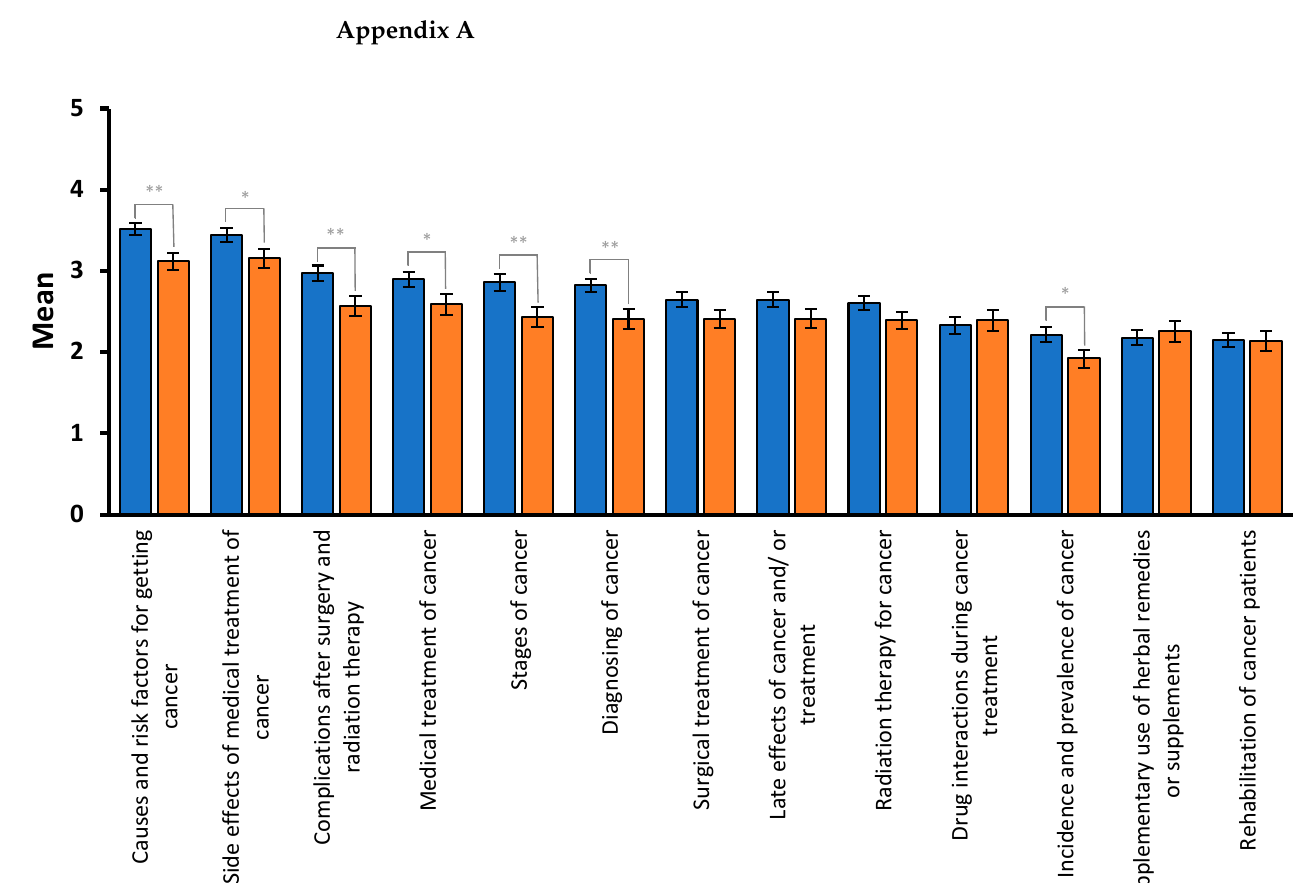
Figure A1. Self-perceived level of knowledge related to the topics about the cancer trajectory and cancer treatment for pharmacists (n = 79) and pharmaconomists (n = 51), respectively. Ratings for knowledge are defined as: 1 No knowledge, 2 very little knowledge, 3 some knowledge, 4 a lot of knowledge, 5 in-depth knowledge. Pharmacists. Pharmaconomists. Error bars are SEM. * p < 0.05, ** p < 0.01.